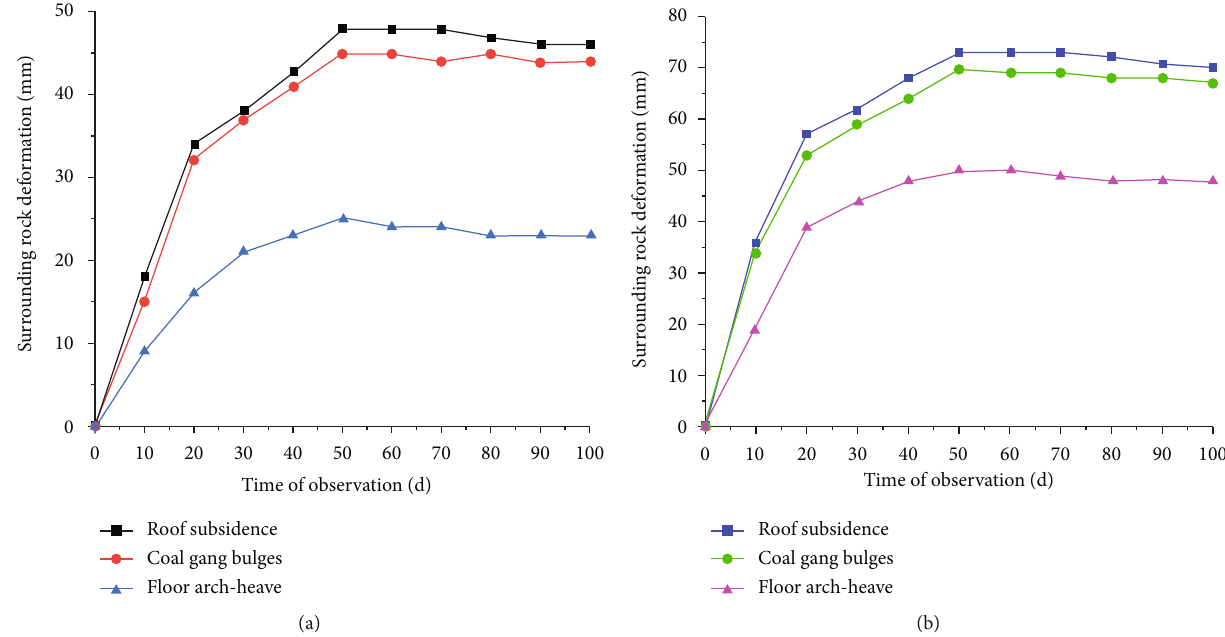
Figure 23: Deformation of roadway surrounding rock during mining of underlying coal seam after repair. (a) Deformation of roadway in mining area during 9# coal seam mining and deformation of roadway in mining area during 15# coal seam